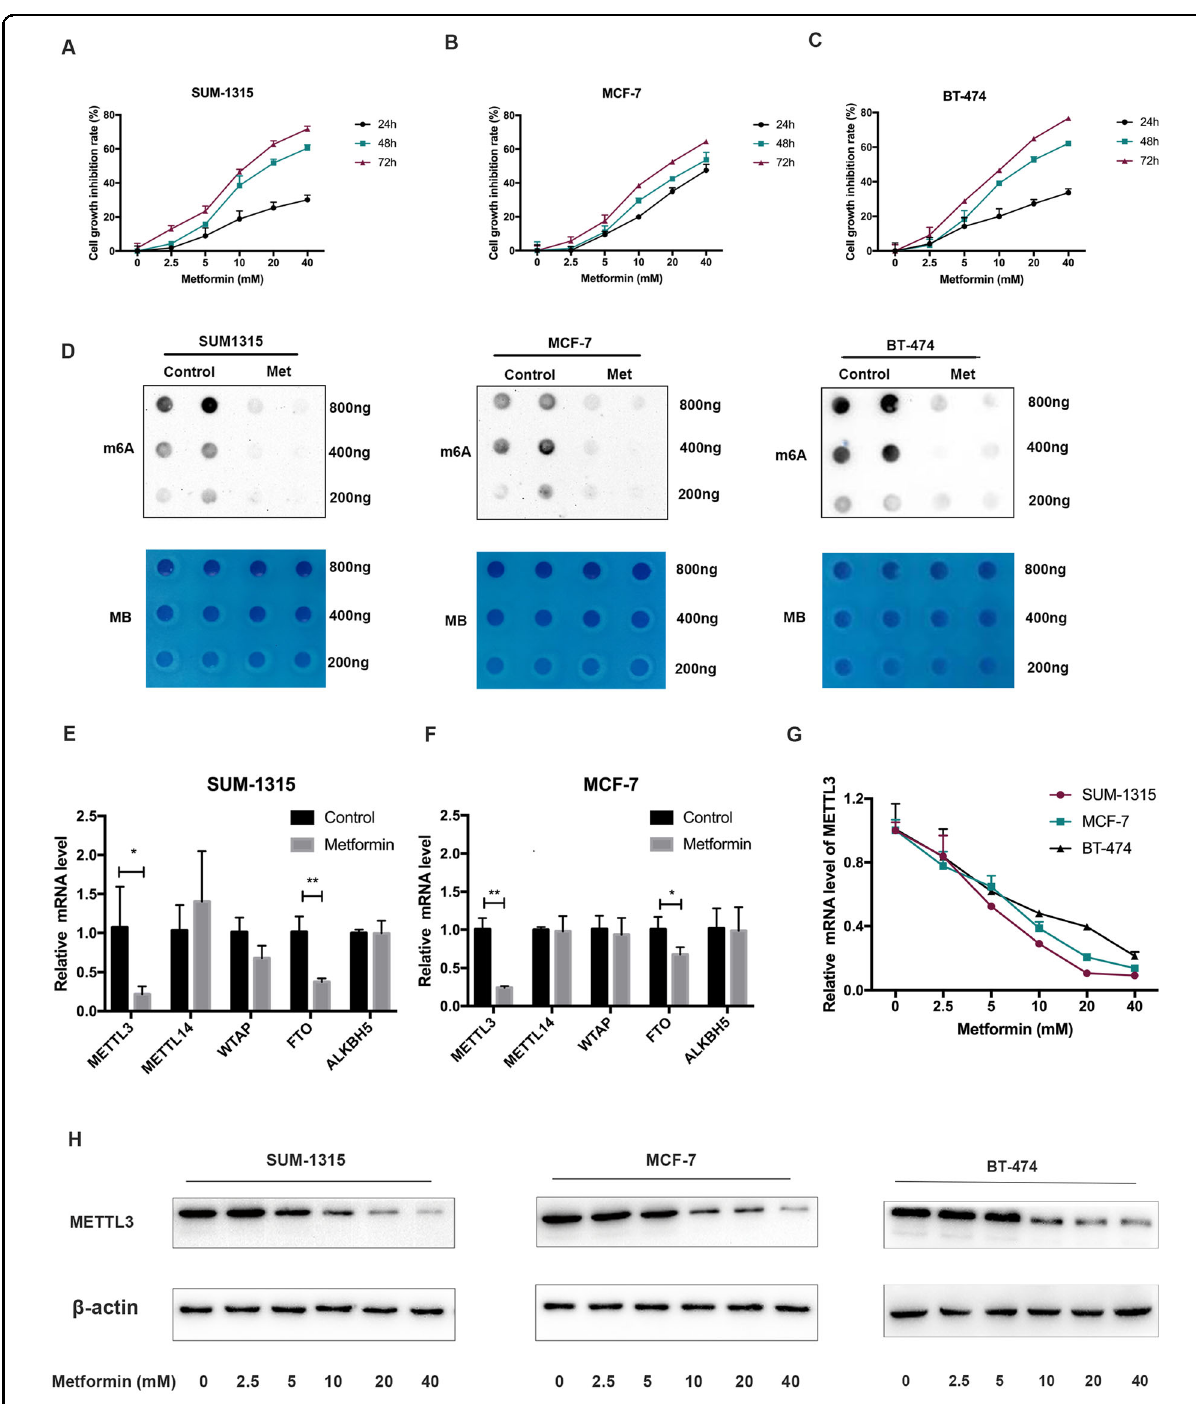
Fig. 1 Metformin reduced the m 6 A level via decreasing METTL3 expression. A – C Metformin inhibited the growth of SUM-1315, MCF-7, and BT- 474 cells in both dose-dependent and time-dependent manners. D Dot-blot assay showed that metformin decreased the m 6 A level in SUM-1315, MCF-7, and BT-474 cells. MB, methylene blue staining (loading control). E , F RNA expression changes of the 5 key m 6 A methyltransferases and demethylases including METTL3, METTL14, WTAP, FTO, and ALKBH5 after the treatment of metformin in SUM-1315 and MCF-7 cells. G , H Metformin decreased the mRNA and protein expression of METTL3 in a dose-dependent manner. The relative RNA level was calculated by the 2 − ΔΔ Ct method and normalized based on β -actin. The average mRNA level of genes mentioned above in the metformin untreated group was set as 1. Data represented the mean ± SD, * p < 0.05, ** p < 0.01 vs metformin-untreated